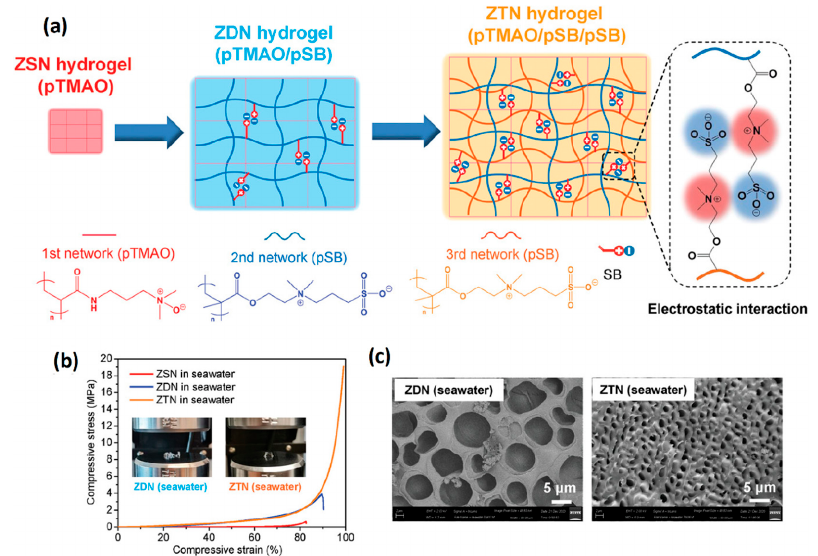
Figure 3. Mechanical strengthening pure zwitterionic hydrogels prepared by multiple networks: ( a ) schematic illustration of ZTN hydrogel with 1st pTMAO network and double pSBMA networks; ( b ) uniaxial compression test of pure zwitterionic hydrogels swelling in seawater. The introduction of the 3rd network further increased both compressive stress and toughness; ( c ) SEM images of multiple network pure zwitterionic hydrogels swelling in seawater. The introduction of the 3rd network further enhances dipole–dipole interaction between zwitterionic units leading to a more compact structure. Reproduced with permission from [81]. Copyright 2021 Wiley-VCH